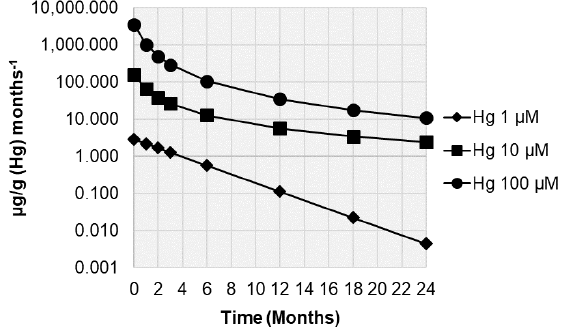
Figure 5. Release rates of Hg (µg/g month − 1 ) in samples of the lichen Evernia prunastri incubated with 1, 10, and 100 µM Hg 2+ solutions and transplanted for 1, 2, 3, 6, 12, 18, and 24 months at the Botanical Garden of the University of Siena.